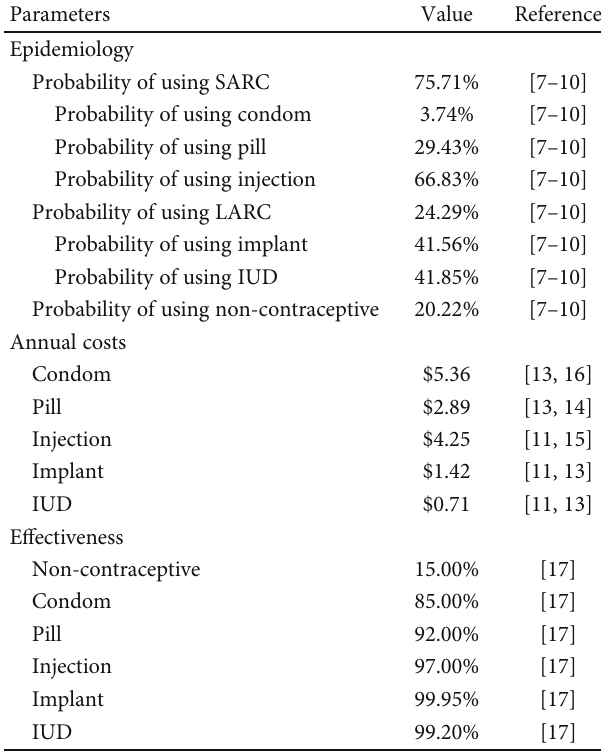
Table 1: Parameter used in the decision tree